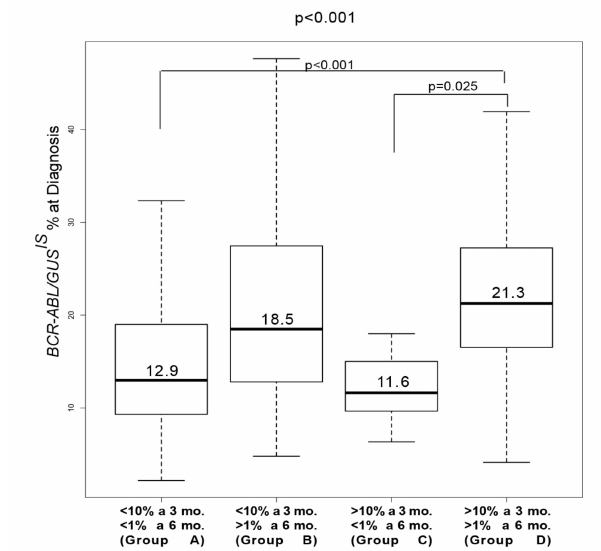
Figure 2. Comparison between BCR - ABL1 / GUS IS levels at diagnosis and BCR - ABL1 / ABL1 IS transcripts at 3 and 6 months. BCR - ABL1 / GUS IS levels were determined for each group and depicted as boxplots delimited by the 25th (lower) and 75th (upper) percentile. Horizontal lines above and below each boxplot indicate the 5th and 95th percentile, respectively. Thick lines in each boxplot represent median BCR - ABL1 / GUS IS in each patients group. The p -value above the figure refers to statistical significance among all four groups included in the analysis while p -values displayed inside the figure refer to statistical significance among the population groups indicated by the bracket (comparison between groups A and D: p < 0.001; comparison between groups C and D: p =